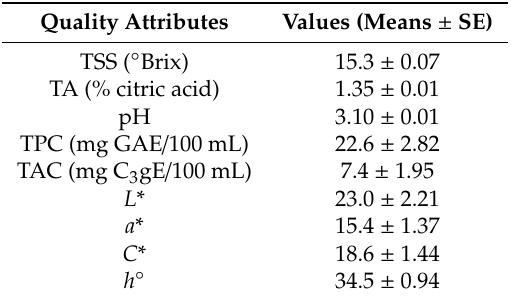
Table 1. Quality attributes of pomegranate juice (cv Wonderful) processed into powders.